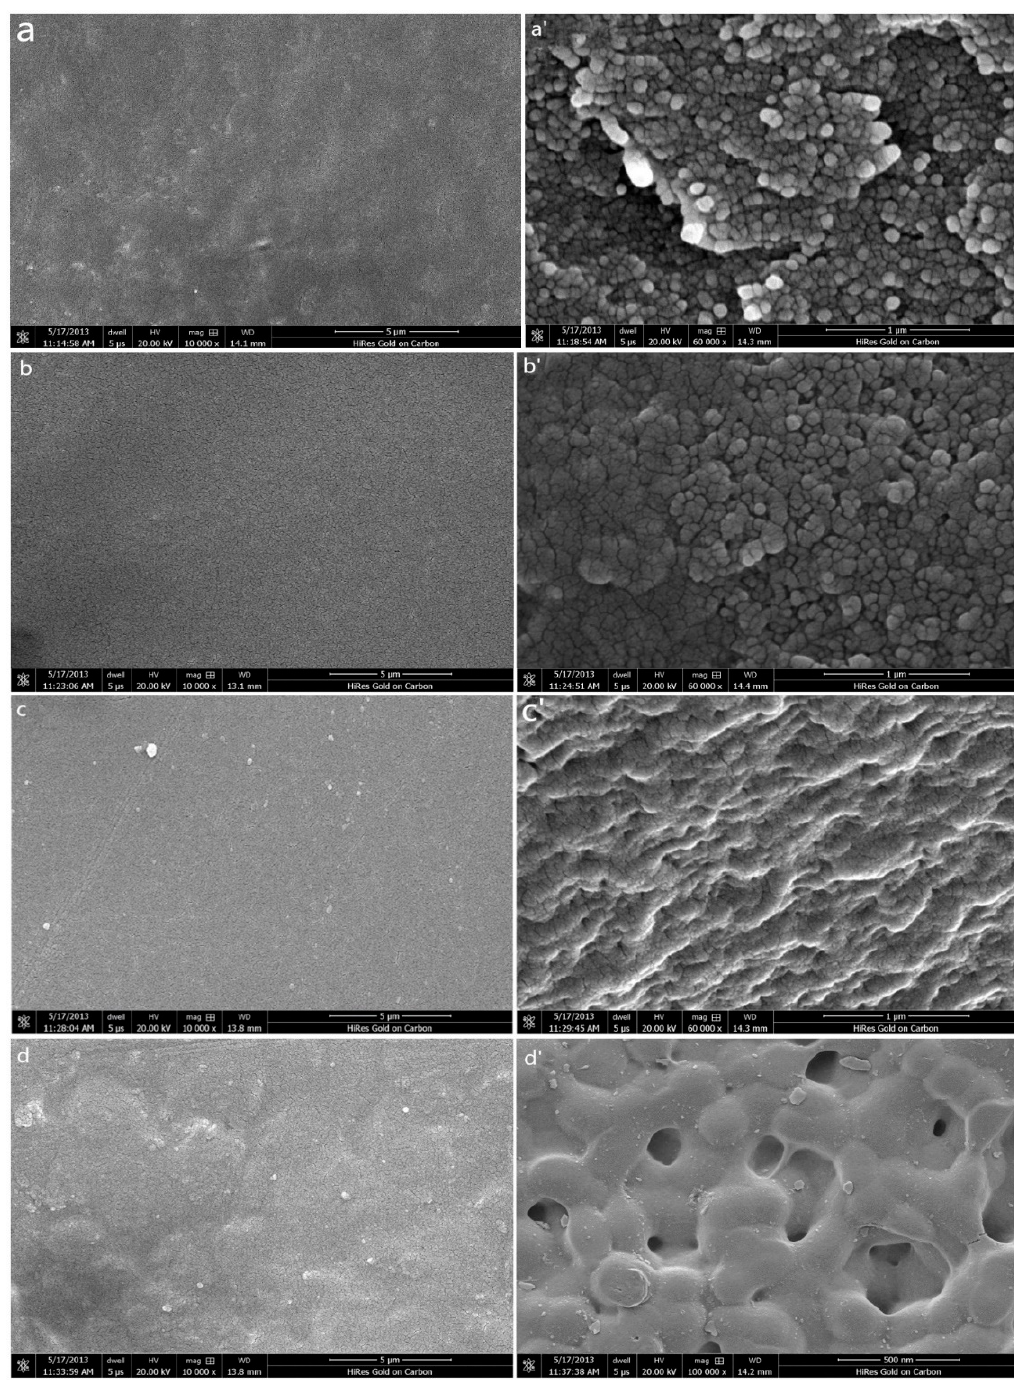
Figure 5. SEM images of prepared membranes (with the weight fraction 1% of non-organic nanoparticles taken as an example). ( a ) PVDF-g-PSSA (surface); ( a’ ) PVDF-g-PSSA (cross-section); ( b ) PVDF/1.0% SiO 2 -g-PSSA (surface); ( b’ ) PVDF/1.0% SiO 2 -g-PSSA (cross-section); ( c ) PVDF/1.0% Al 2 O 3 -g-PSSA (surface); ( c’ ) PVDF/1.0% Al 2 O 3 -g-PSSA (cross-section); ( d ) PVDF/1.0% ZnO-g-PSSA (surface); ( d’ ) PVDF/1.0% ZnO-g-PSSA (cross-section).